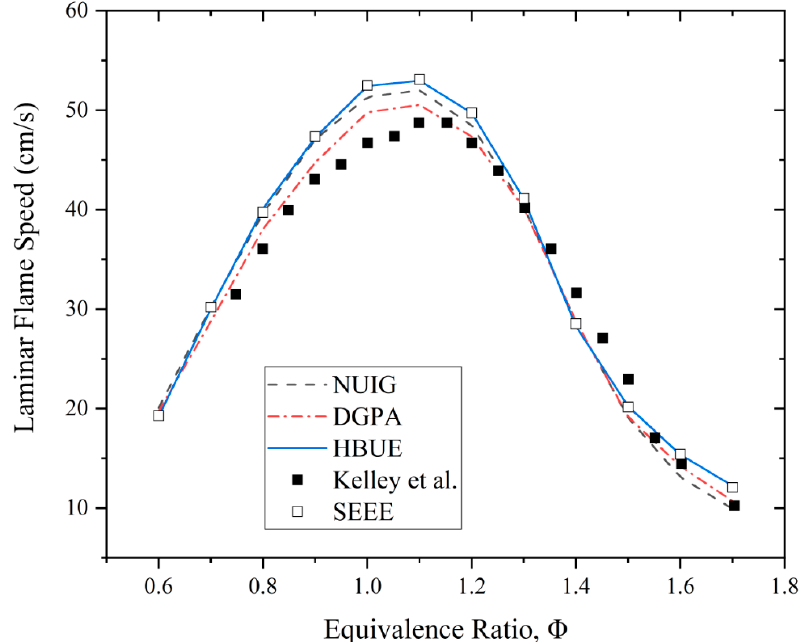
Figure 10. Comparison of the laminar flame speeds between NUIG, DGPA, HBUE, SEEE, and experimental data at equivalence ratios of 0.6–1.7 and an unburned gas temperature of 353 K.